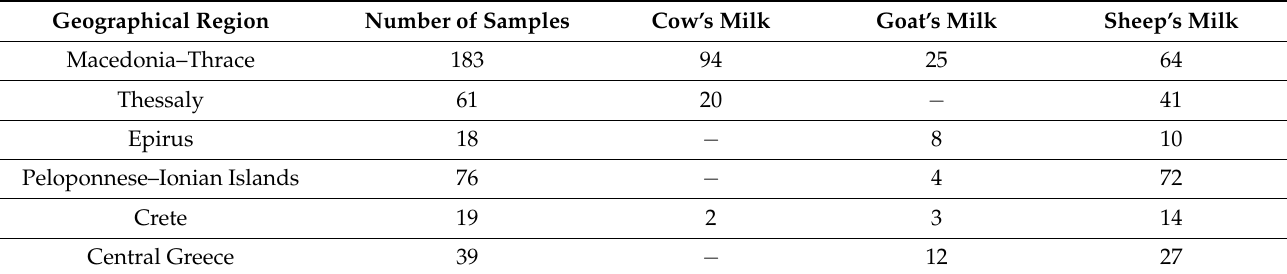
Table 3. Testing of raw milk samples for the presence of AFM1-Distribution by region and type of milk. Geographical Region Number of